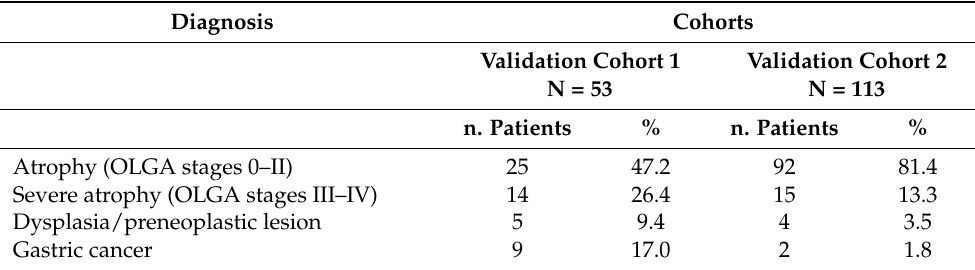
Table 3. Aggregation of participants according to histopathological